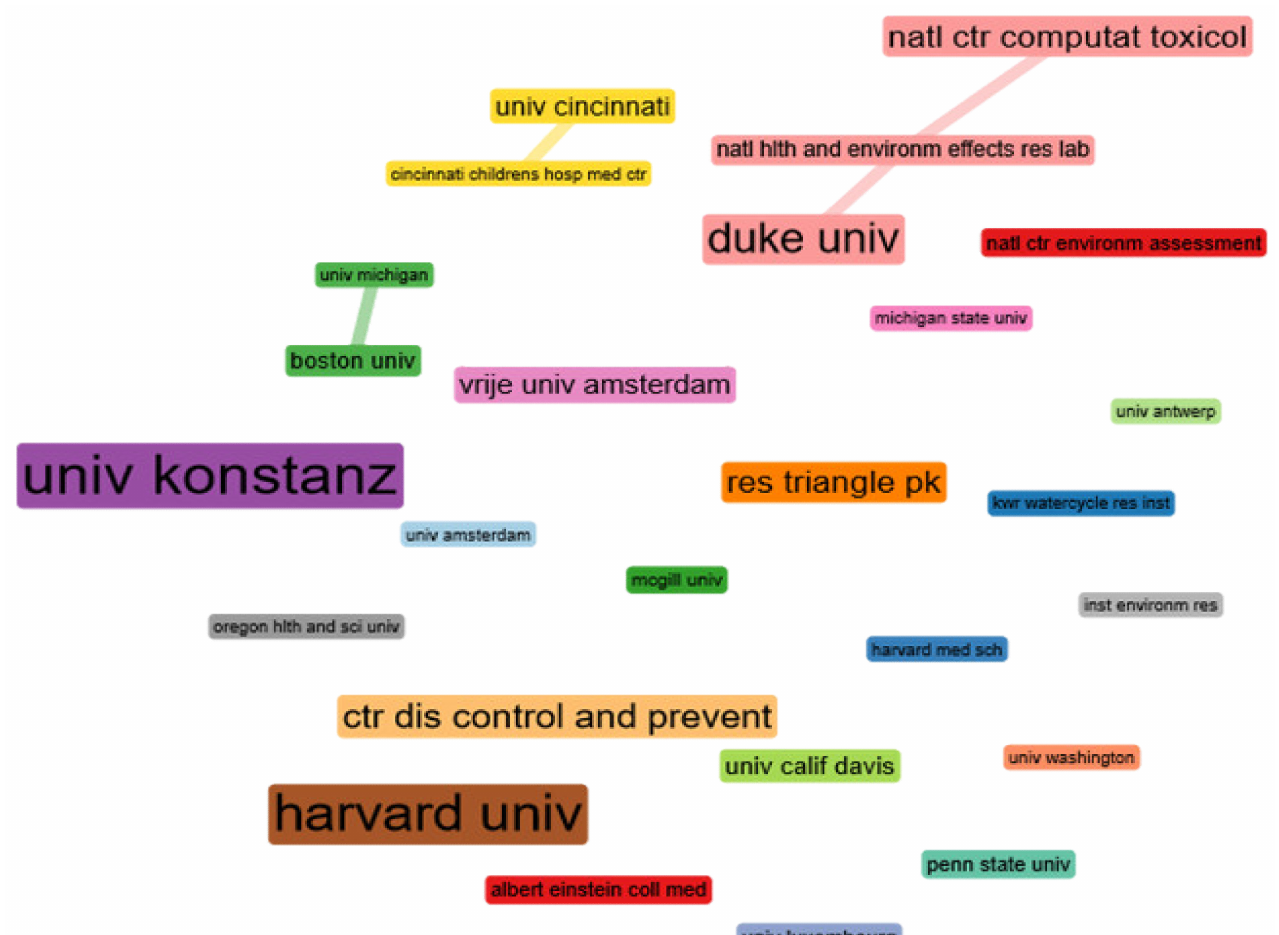
Figure 4. Network of collaboration among institutions from 2011 to